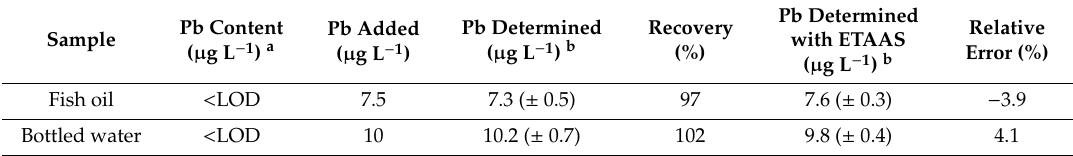
Table 1. Recovery of Pb(II) in Spiked Samples and Comparison with